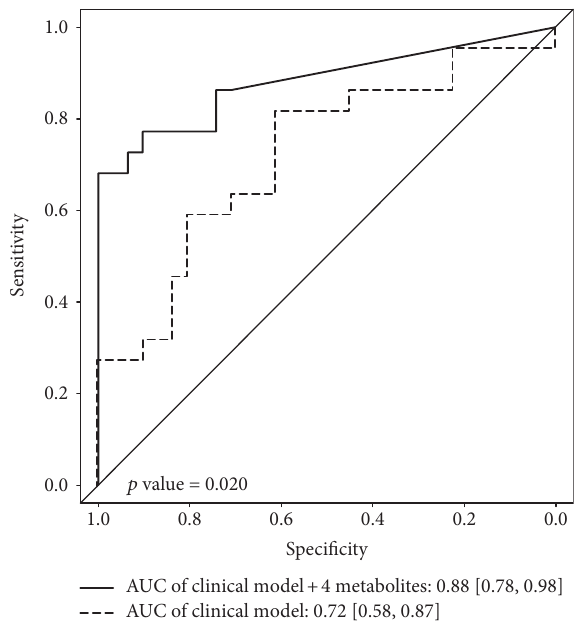
Figure 3: Comparison of sensitivity and speci fi city with and without the four metabolites. ROC curves and measures of model fi t (AUC) are presented for (1) model with clinical parameters (sex, age, BMI, HbA1c, diabetes duration, SBP, DBP, antihypertensives, TG, LDL :HDL ratio, lipid-lowering agents, albumin, and eGFR; dashed line) and (2) model combining the four selected metabolites and the clinical model (solid